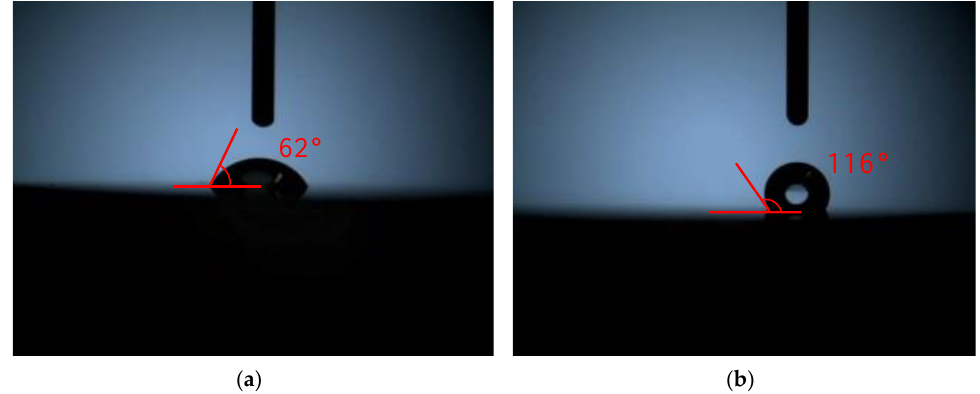
Figure 10. The water contact angle of untreated ( a ) double-layer broadband film and the film after treatment ( b ).